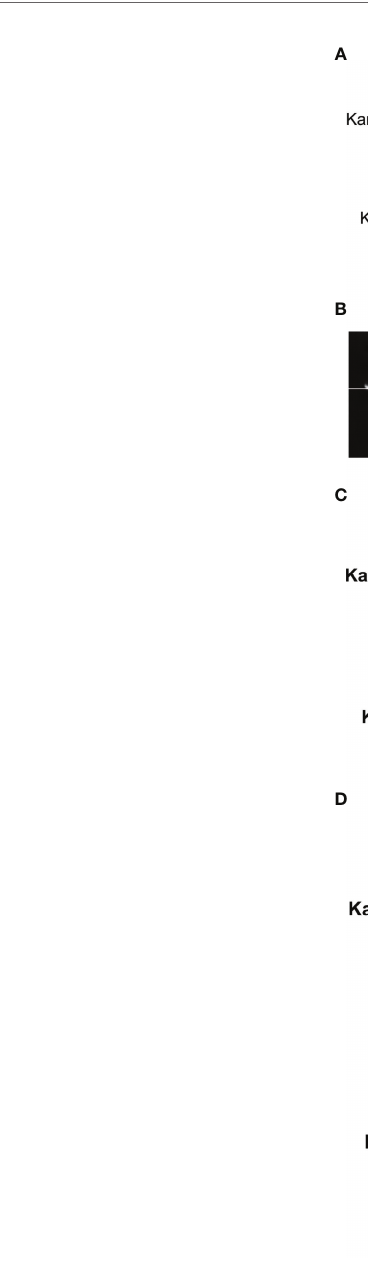
FIGURE 3 | Sensitivity and speci fi city of KarlTa and Kare primer pairs. (A) : Gel electrophoresis of annealing temperature gradient of KarlTa and Kare primer pairs (KarlTa, 1: 47 °C; 2: 49 °C; 3: 51 °C; 4: 53 °C; 5: 55 °C; 6: 57 °C; 7: 59 °C; 8: 61 °C; M: DL2000 DNA marker; Kare, 1: 46 °C; 2: 48 °C; 3: 50 °C; 4: 52 °C; 5: 54 ° C; 6: 56 °C; 7: 58 °C; M: DL2000 DNA marker. The horizontal line indicates the correct size of target bands). (B) : Gel electrophoresis of sensitivity of KarlTa and Kare primer pairs (1: 10 ng, 2:2 ng, 3: 0.4 ng, 4: 0.08 ng, 5: 16 pg, 6: 3.2 pg, 7: 0.64 pg, 8: 0.128 pg of DNA template content; M: DL2000 DNA marker. The horizontal line indicates the correct size of target bands). (C) : Gel electrophoresis of speci fi city of KarlTa and Kare primer pairs (S1: A. paci fi cum ; S2: P. obtusidens ; S3: Chattonella sp.; S4: H. akashiwo ; S5: A. anophagefferens ; S6: G. catenatum ; S7: A. carterae ; S8: S. acuminata ; S9: S. costatum ; S10: P. tricornutum ; S11: C. closterium ; S12: P. globosa ; S13: I. galbana ; S14: Chlorella sp.; S15: A. sanguinea ; C1 (KarlTa) & NC1 (Kare): Karl. vene fi cum ; C2 (KarlTa) & NC2 (Kare): T. xiamenensis ; NC (KarlTa) & C (Kare): K. mikimotoi ; M: DL2000 DNA marker. The horizontal line indicates the correct size of target bands). (D) : Validation results of KarlTa and Kare primers with laboratory samples ( Karlodinium (1-6): 1-4: Karl. vene fi cum Kv-LYG1, Kv-LYG2, Kv-LYG5, and Kv-lu; 5: Karl. ballantinum TIO1456; 6: Karl. zhouanum GM8; Takayama (7-10): 7-9: T. xiamenensis TX-LYG2, TX-LYG3, C2-M-3; 10: T. tasmanica CAWD115; Karenia (11-17): 11-12: K. mikimotoi KM2019, KM201; 13: K. selliformis CAWD79; 14: K. brevisulcata CAWD82; 15: K. papilionacea CAWD91; 16: K. bicuneiformis CAWD92; 17: K. brevis CAWD122; M: DL2000 DNA marker. The horizontal line indicates the correct size of target